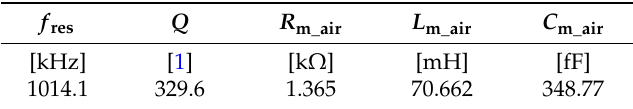
Table 1. Characterization of the resonator in air. R m_air , L m_air , and C m_air represent the unperturbed resonator in air.